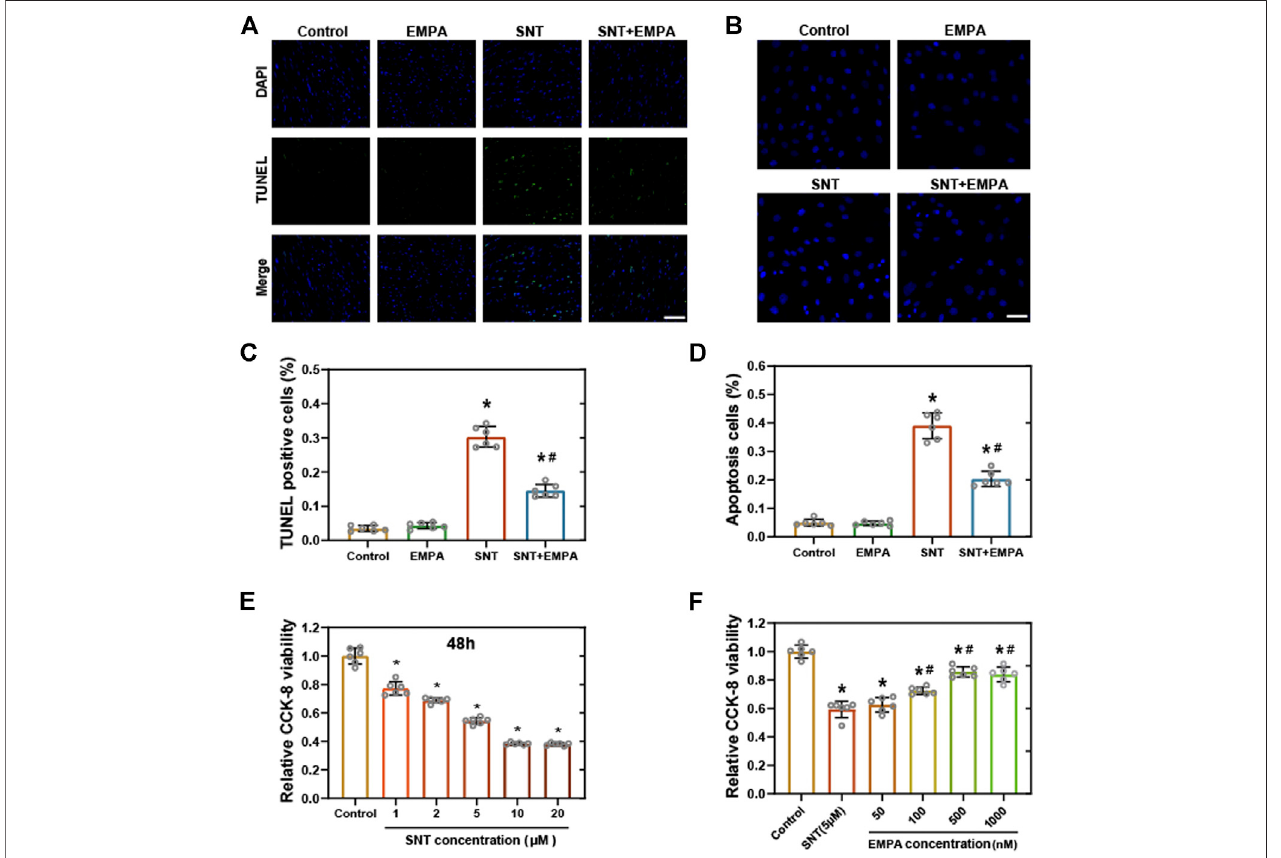
FIGURE 4 | EMPA ameliorated SNT-triggered cardiomyocyte death and cell viability loss. (A) Representative images of TUNEL positive cells in mice hearts at the studyendpointamongdifferentgroupsand (C) statisticalanalysis, n (cid:1) 6pergroup,bar (cid:1) 50 μ m. (B) RepresentativeimagesofHoechst33,258staininginH9c2cellswith different treatments and (D) statistical analysis, n (cid:1) 6 per group, bar (cid:1) 50 μ m. (E) CCK-8 viability assay of H9c2 cardiomyocytes treated with vehicle or different concentrations of SNT (ranging from 1 to 20 μ M), n (cid:1) 6 per group. (F) CCK-8 viability assay of H9c2 cardiomyocytes treated by vehicle, SNT (5 μ M), or SNT plus EMPA (ranging from 50 to 1,000 nM), n (cid:1) 6 per group. * p < 0.05 vs. control, # p < 0.05 vs.